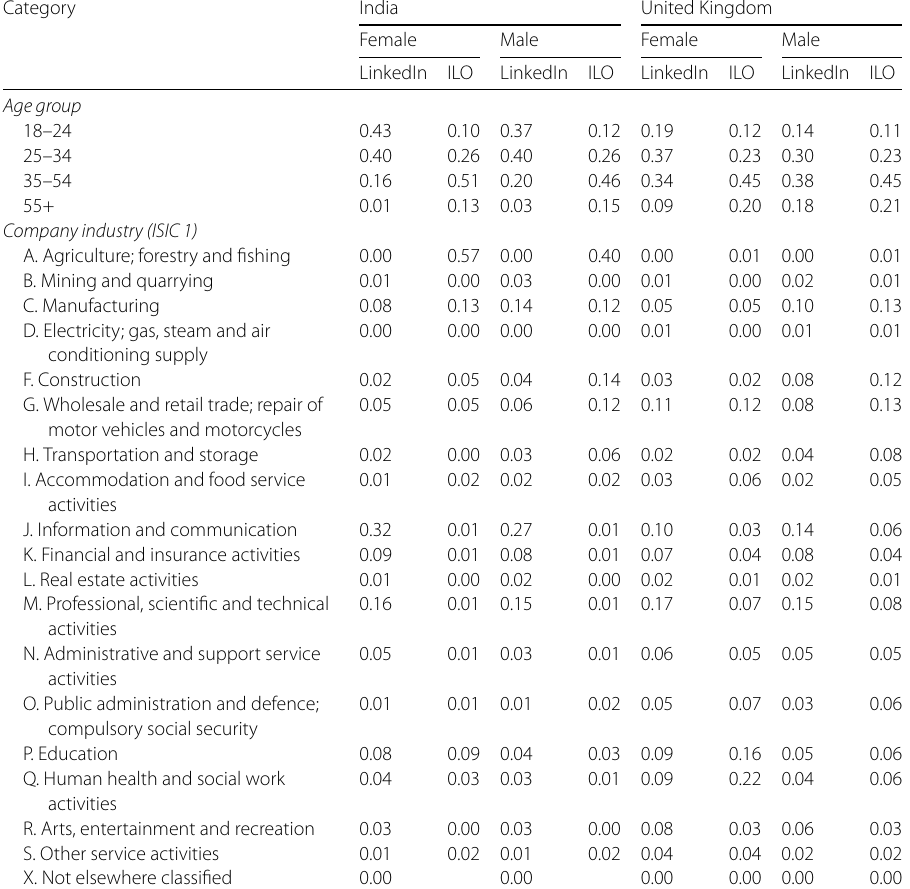
Table 7 Proportions of LinkedIn audience counts by age and company industry, disaggregated by gender for India and the UK